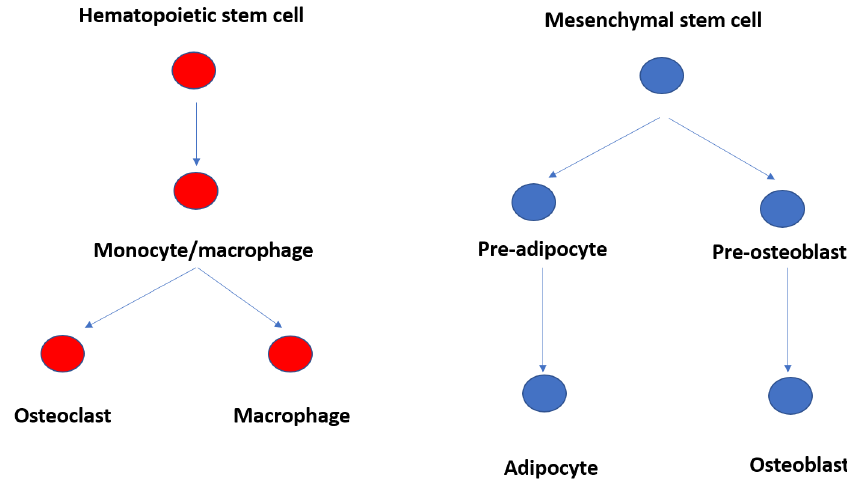
Figure 1. Ontogeny of fat, osteoblast, and osteoclast cells in bone